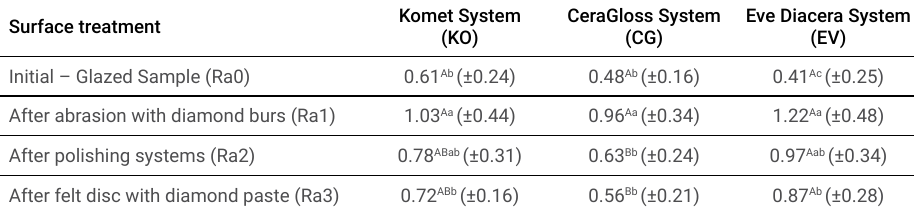
Table 2. Surface roughness values (μm) and standard-deviations of the different